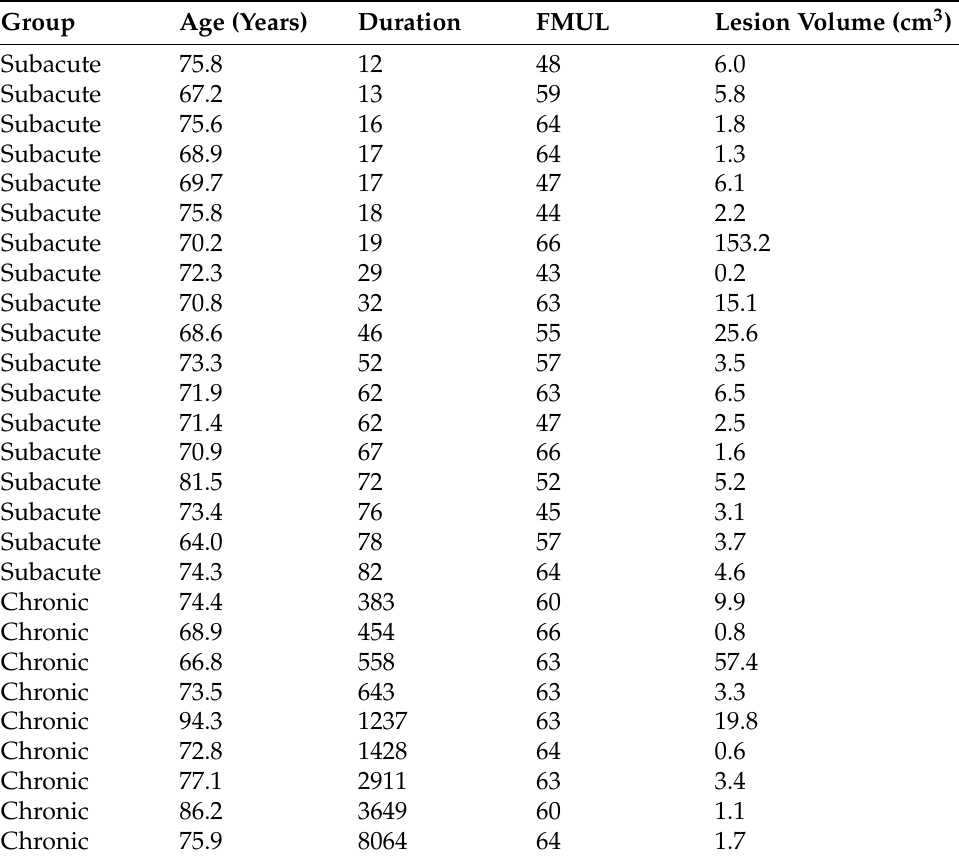
Table 1. General characteristics of the included